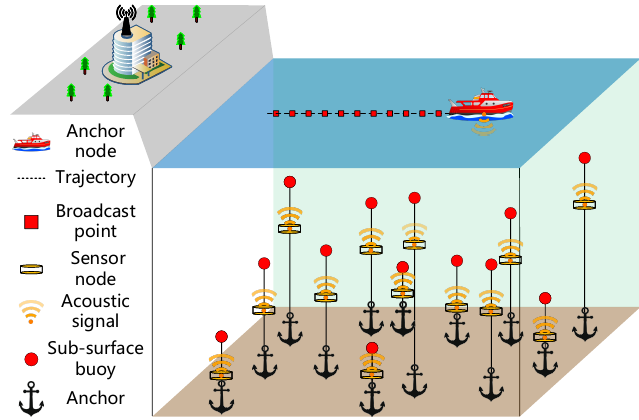
Figure 1. The network system architecture of the proposed localization scheme.